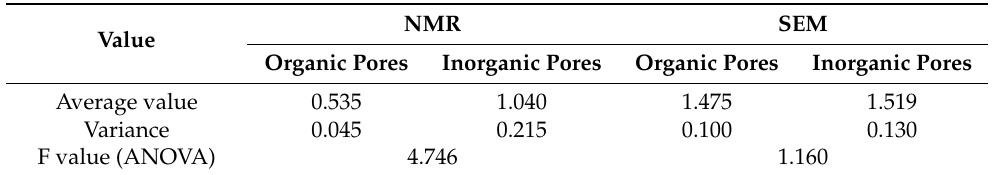
Table 6. The average values and variances of ∆ α for organic and inorganic shale pores obtained using NMR and SEM. NMR SEM Value Organic Pores Inorganic Pores Organic Pores Inorganic Pores